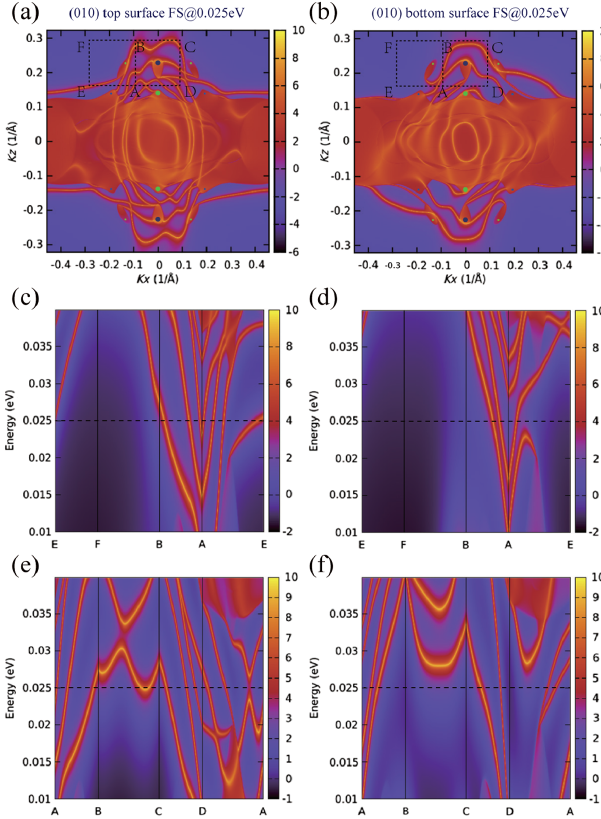
FIG. 9. Surface state of the first cleaved cell with a surface potential energy of 0.4 eV. (a,b) Fermi surface on the top and bottom (010) surfaces, respectively. The small dots represent the single projected WP, and the large dots represent two WPs with the same chirality projecting on top of each other. Panels (c) and (e) are the surface states of the top surface along the closed paths of E-F-B-A-E and A-B-C-D-A, respectively. Panels (d) and (f) are the same as (c) and (e) but for the bottom surface.